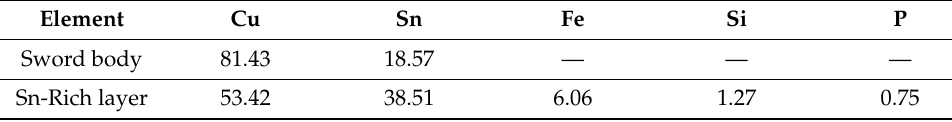
Figure 4. Cross-section EDS line-scan profiles of the sword: ( a ) left side; ( b ) right side. Table 1. Chemical compositions of the sword (wt.%).